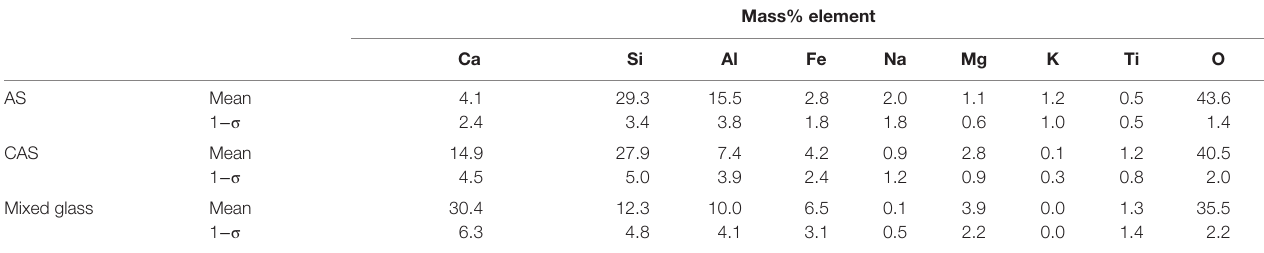
TaBle 3 | Phase compositions and uncertainties expressed as a single sD ( σ ) for n ≥ 3 analyses of glasses in a single sample of cc fly